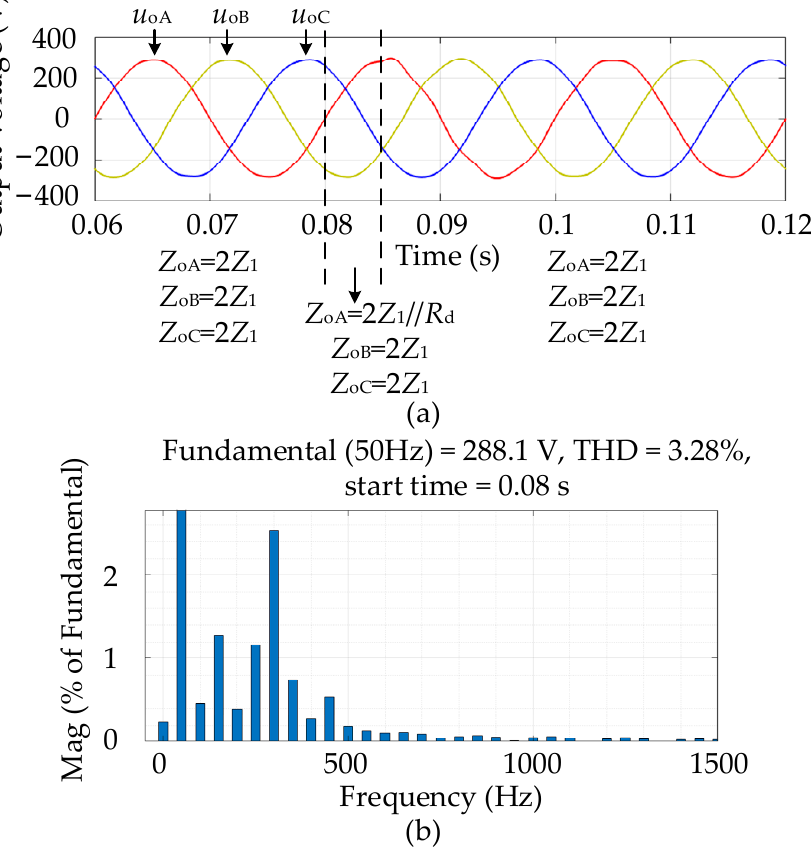
Figure 14. ( a ) The output voltage of each phase when the disturbance load was added to the A-phase. ( b ) The FFT result of the A-phase output voltage.